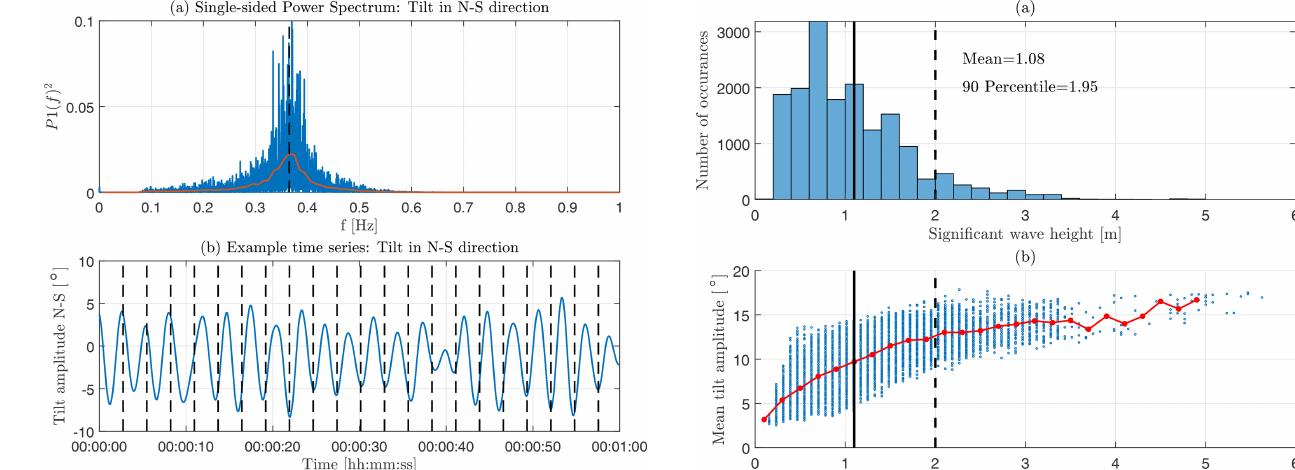
Figure 12. (a) Histogram of significant wave heights experienced during an offshore trial of the SWLB at East Anglia One met mast from March through July 2016. Mean and 90th percentile signifi- cant wave height listed in the plot. (b) Scatter plot of mean tilt am- plitude and significant wave height (blue) including mean tilt am- plitude binned by significant wave heights (red). Vertical solid and dashed lines mark the normal and strong wave cases,